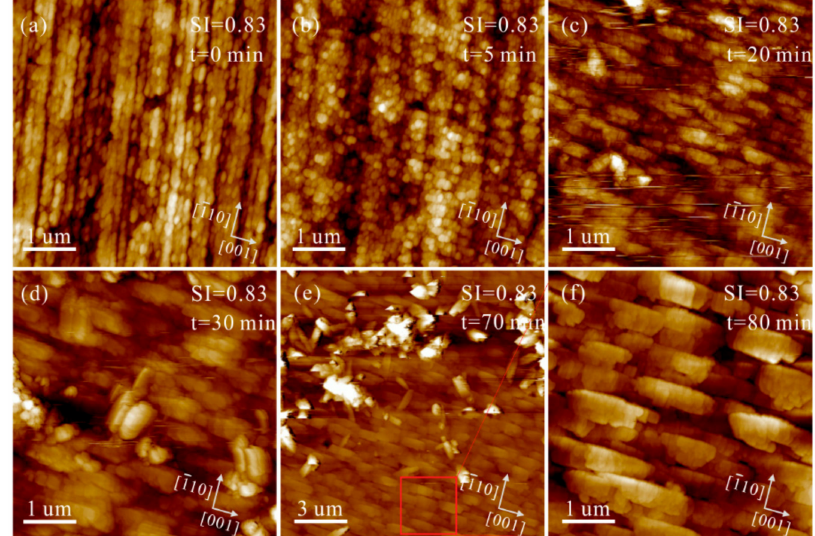
Figure 8. AFM height images of the polished aragonite (110) surface in the solution (Mg 2 + / Ca 2 + = 3, SI calcite = 0.83) under flowing conditions at pH = 8.0 ± 0.1 for ( a ) 0, ( b ) 5, ( c ) 20, ( d ) 30 and ( e ) 70 min, and ( f ) represents the same zone marked with red box in ( e ), which grows for 80